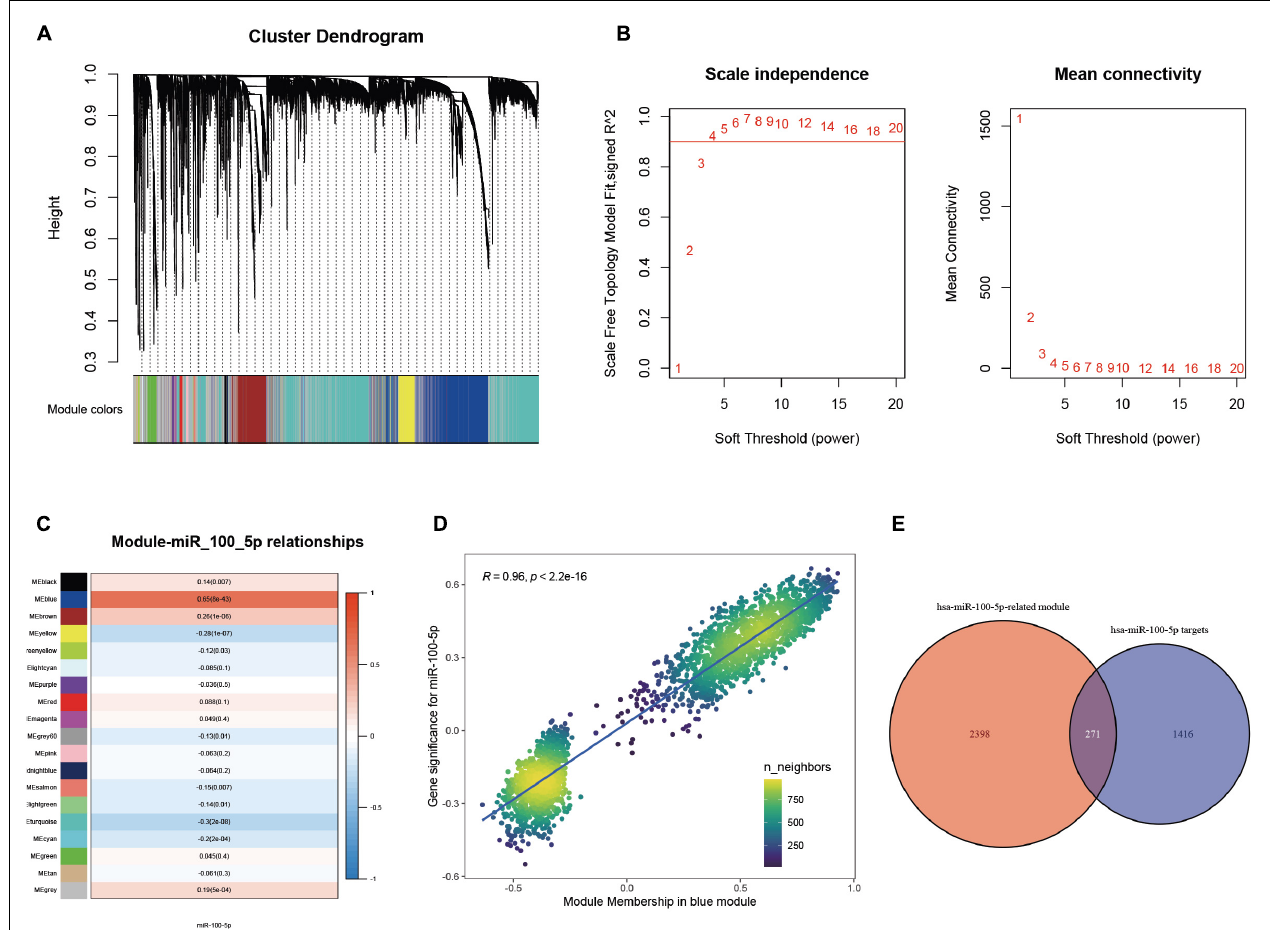
FIGURE 3 | Selection of miR-100-5p-related candidate genes. (A) The cluster dendrogram of genes in TCGA-STAD. Each branch in the figure represents one gene; meanwhile, every color below represents one co-expression module. (B) Analysis of the scale-free fit index for a variety of soft-thresholding powers. (C) The relationships between miR-100-5p expression and various gene modules. (D) The correlation between gene significance for miR-100-5p and module membership in the blue module. (E) Candidate genes were screened by taking interaction with hsa-miR-100-5p targets and genes in the hsa-miR-100-5p-related module.